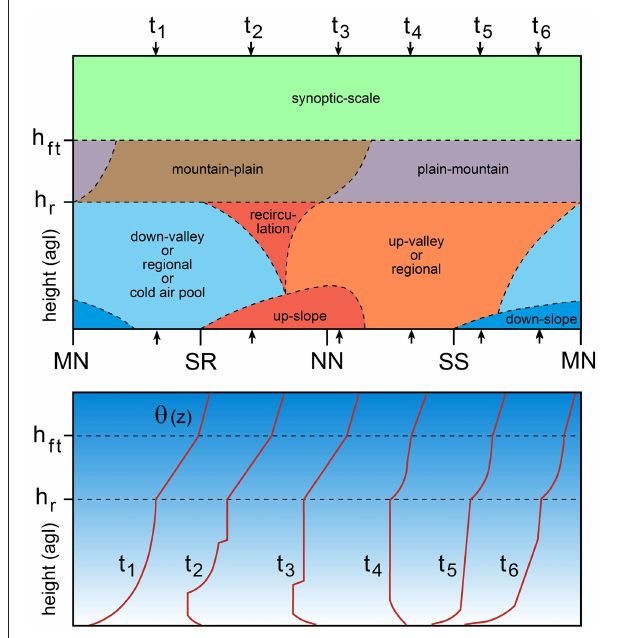
FIGURE 3 | Diurnal boundary layer structure over a slope. Upper panel: time-height section of airflow regimes over a slope during fair weather conditions. h r and h ft are the height of surrounding ridges and the base height of the free troposphere, respectively. Ticks on the time axis indicate midnight (MN), sunrise (SR), noon (NN), and sunset (SS). Lower panel : vertical profiles of potential temperature θ (z) over the slope at selected times t 1 to t 6 marked in the upper panel by small